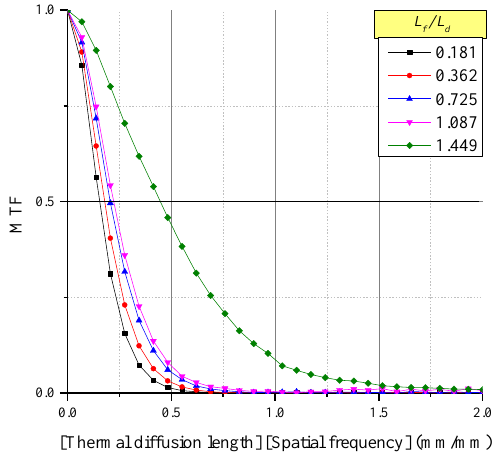
Figure 11. Performance of the MTF according to changes in 𝐿 𝑓 /𝐿 𝑑 .